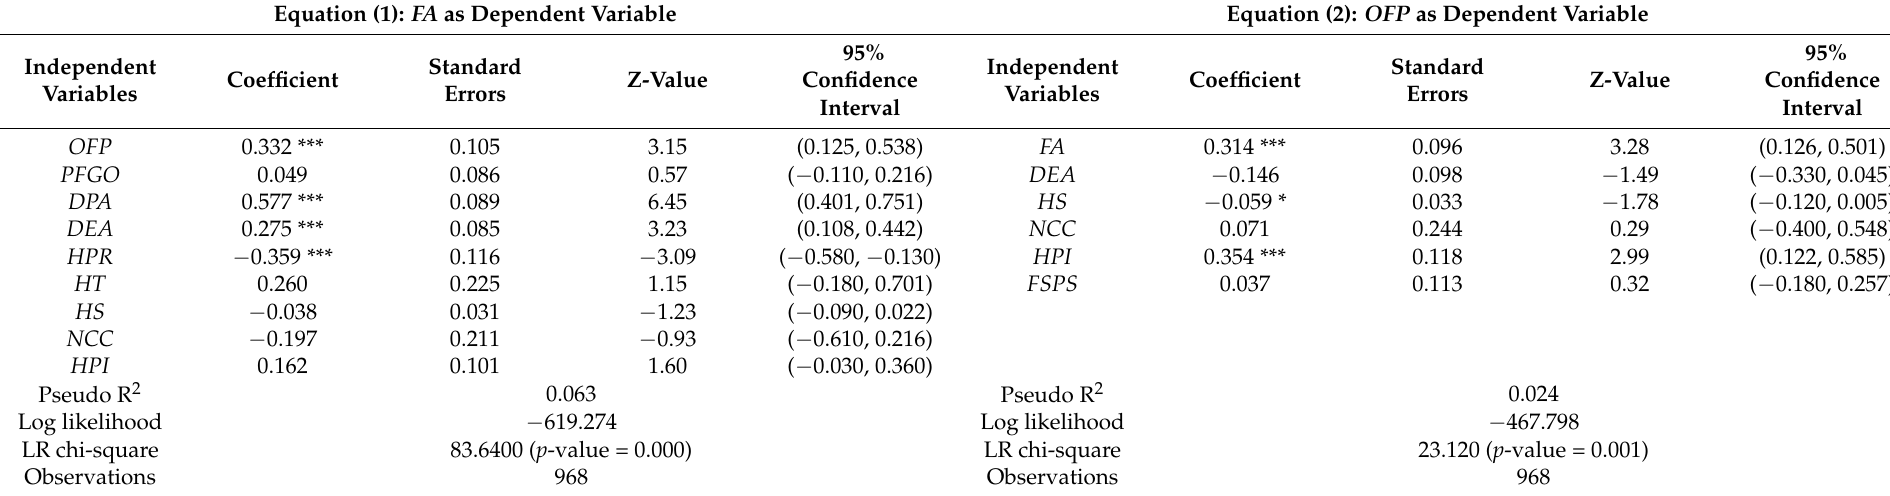
Table 4. Estimated results of simultaneous equations: model